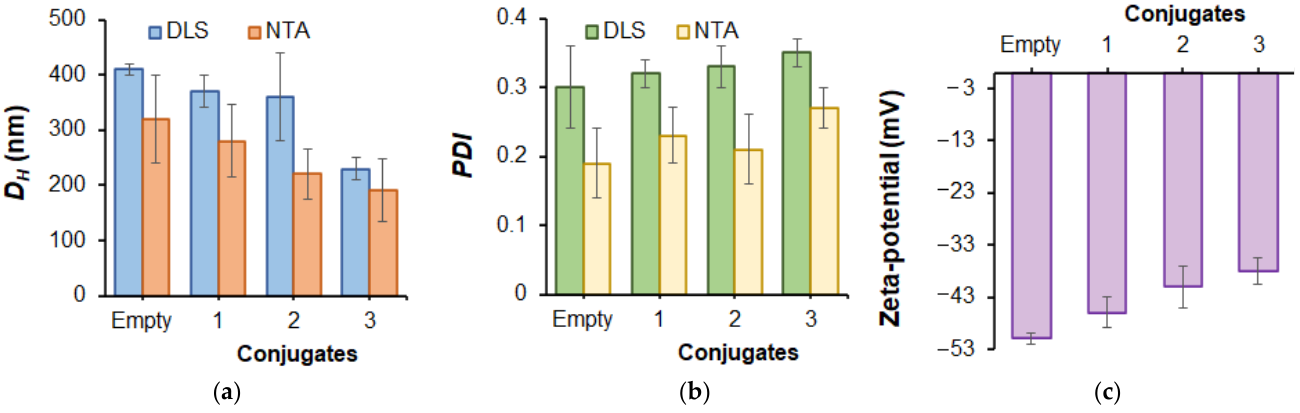
Figure 4. Characteristics of self-assembled empty P(VSAA- co -VSI) and PMX B-conjugated nanopar- ticles determined by dynamic light scattering, nanoparticle tracking analysis and electrophoretic light scattering: hydrodynamic diameter ( D H ) ( a ), polydispersity index (PDI) ( b ) and zeta-potential ( c ). Conjugates were differed by the amount of conjugated PMX B: 1–282 μ g/mg polymer; 2–368 μ g/mg polymer; 3 – 415 μ g/mg polymer (for other details see Table 3).